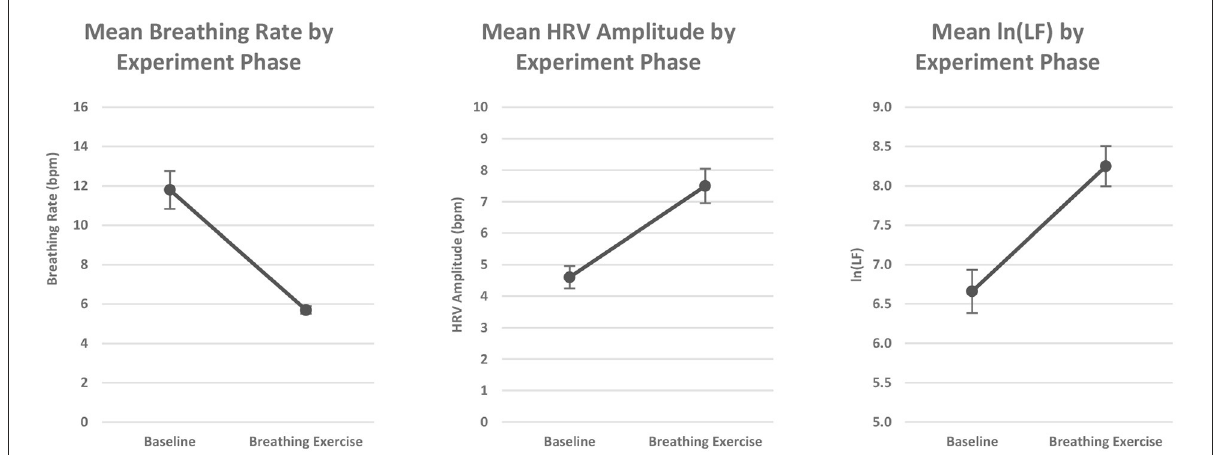
FIGURE5 Grand mean outcome measures scores broken down by experiment phase. (Left) Breathing rate; (Middle) HRV amplitude; (Right) ln(LF). Error bars depict standard error of mean